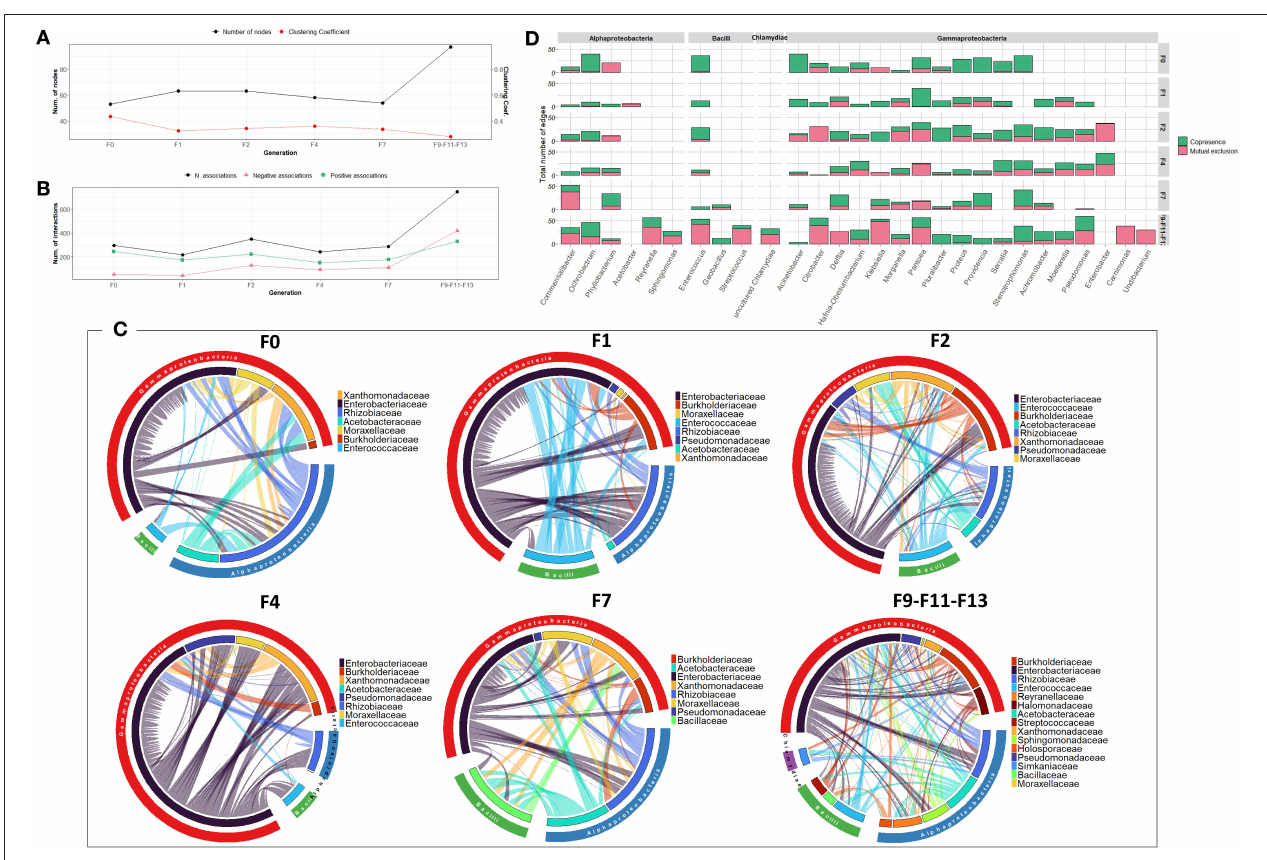
FIGURE 6 | Bacterial community network within the guts of C. capitata teneral during laboratory adaptation of wild population. (A) Total number of nodes and clustering coefficient. (B) Total number of negative (red) and positive (green) associations. (C) Chord diagram displaying direct relationship between OTUs at the family level. The size of the ribbon is proportional to the weight of the association between the OTUs assigned to the respective segments and the color of the ribbon present in the direction of the interaction. (D) Number of positive and negative associations at the genus